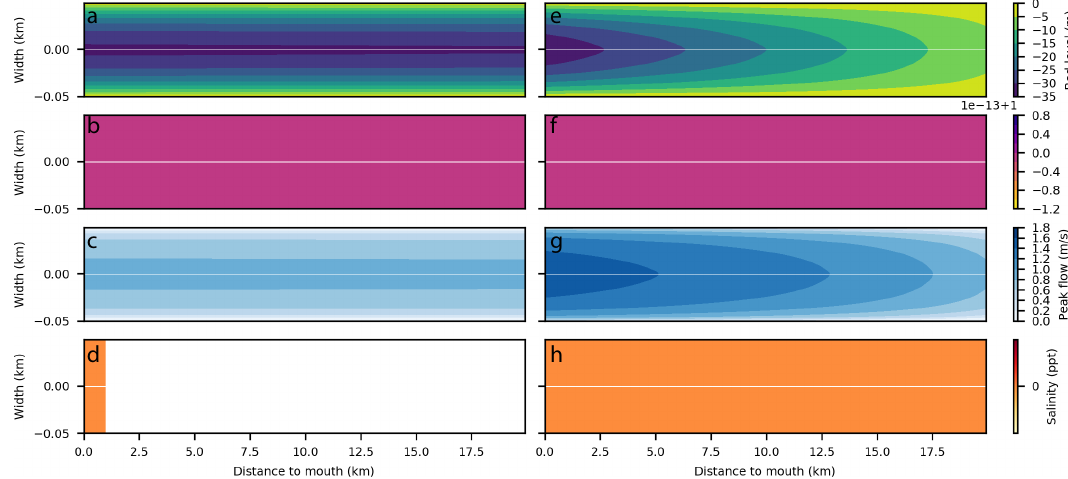
Figure A6. Resulting predictions of bed elevation with respect to the high water level, inundation duration, peak flow velocity and salinity for a river based on dimensions of a distributary of the Saskatchewan River, Cumberland Lake (Saskatchewan (Canada), coordinates: 54 ◦ 04 (cid:48) N 102 ◦ 22 (cid:48) W) (Figure 2a). In the left panels ( a – d ) the boundary condition for maximum depth at the mouth and the landward end are both based on hydraulic geometry for rivers (Equations (6)–(8)). In the right panels ( e – h ), the boundary condition for maximum depth at the mouth is based on the tidal prism relation (Equations (10) and (12)) and boundary condition at the landward end is based on hydraulic geometry for rivers (Equations (8)–(6)). See Bolla Pittaluga et al. [80] for measurements in this river.